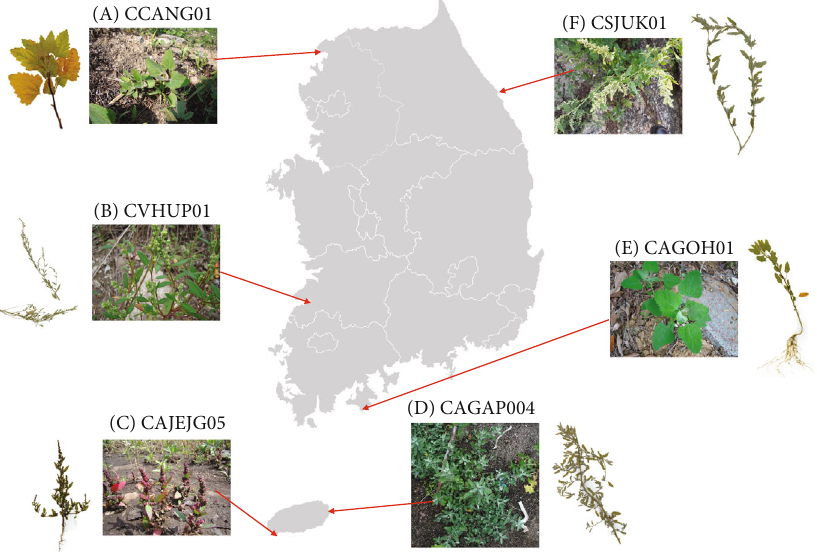
Figure 1: Geographical distribution of six Chenopodium album . The red arrows indicate the locations where six C. album samples were collected in South Korea. Pictures of voucher specimen were displayed on the left or right side of pictures habit in situ of the six